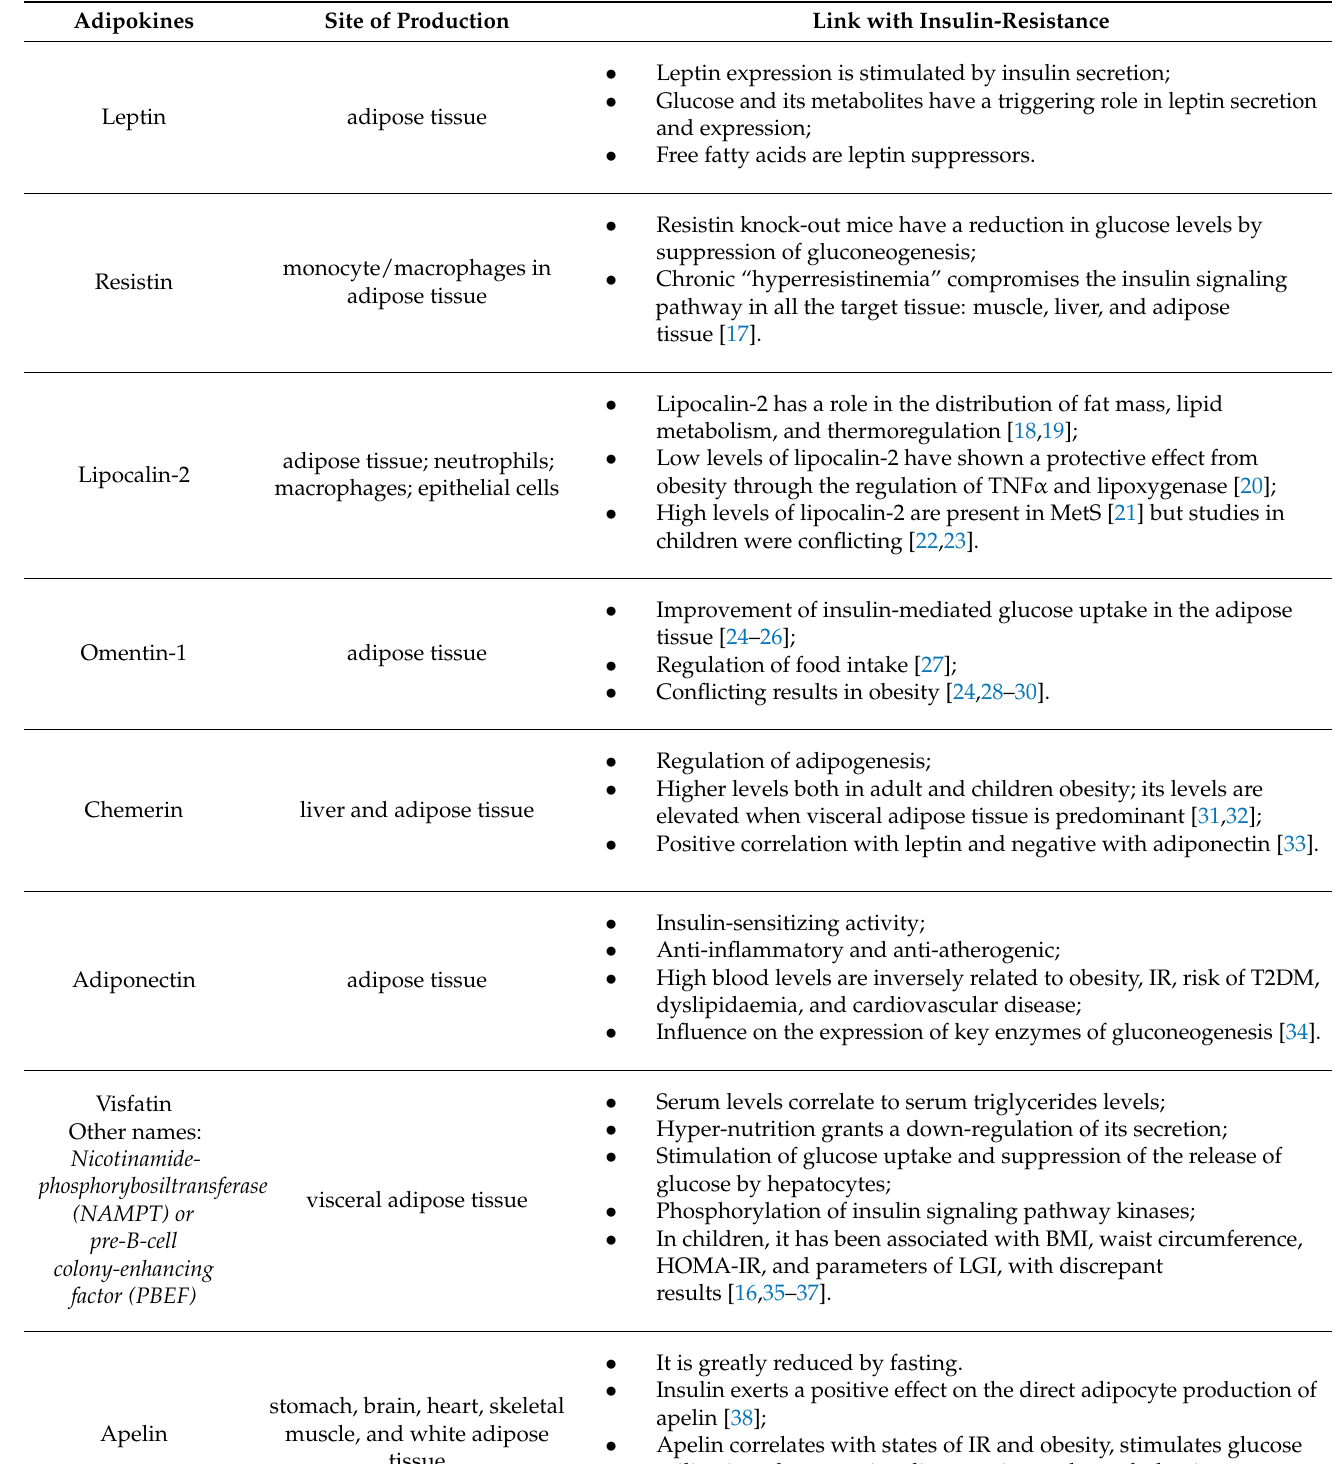
Table 1. Adipokines and their relation to